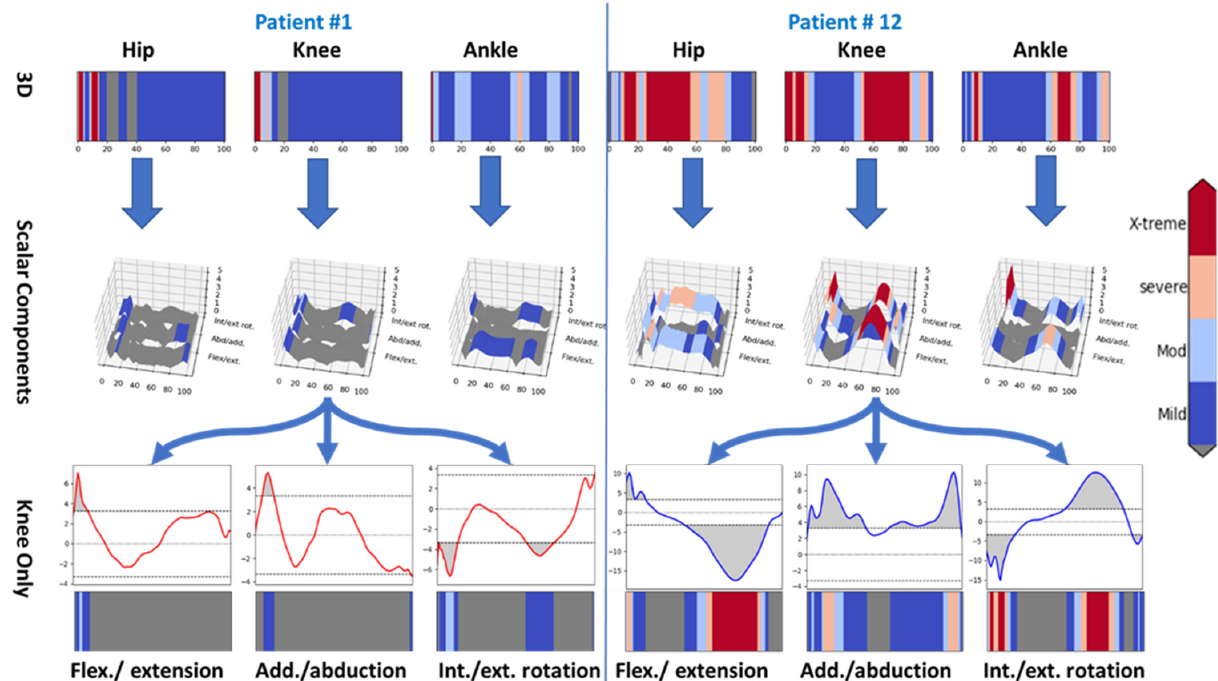
Figure 6. Comparison between two cases with different contralateral limb status. Grey areas represent no significant (subthreshold) effect.